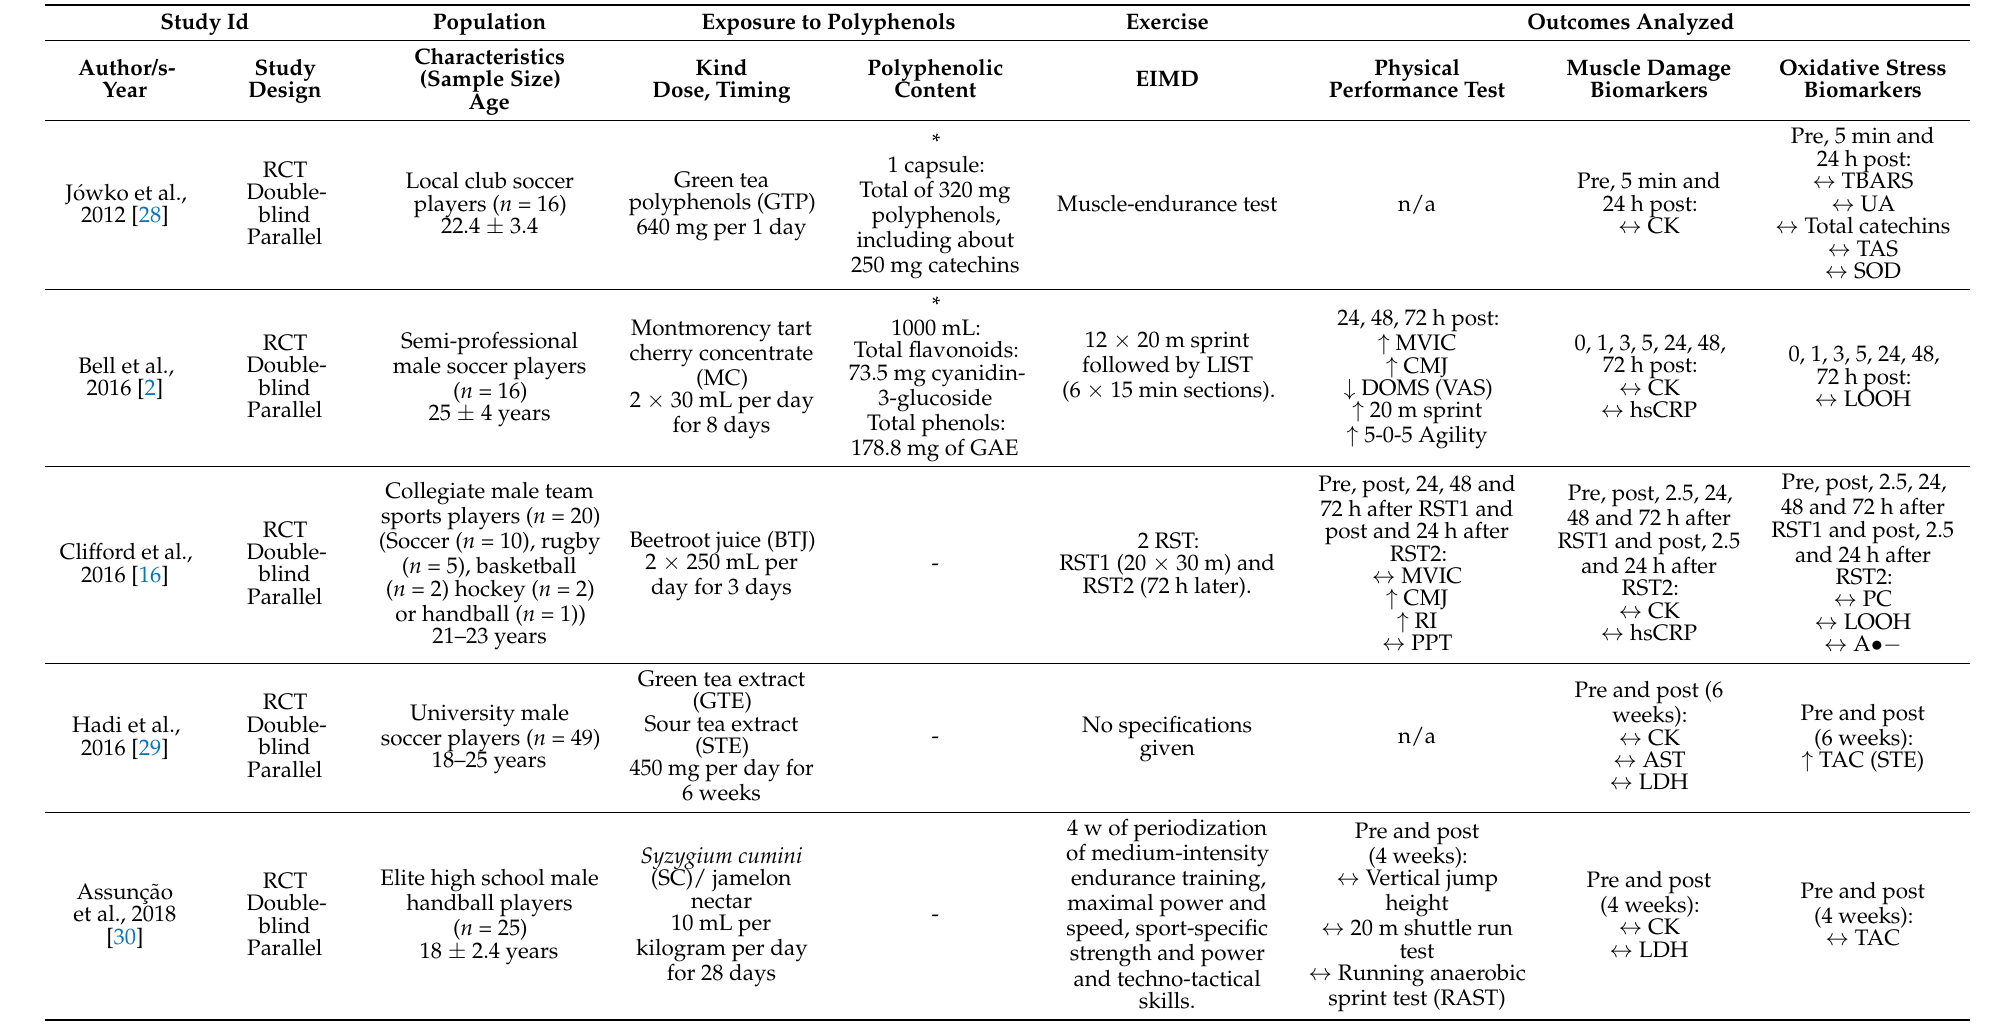
Table 1. RCT design characteristics for all studies included in this